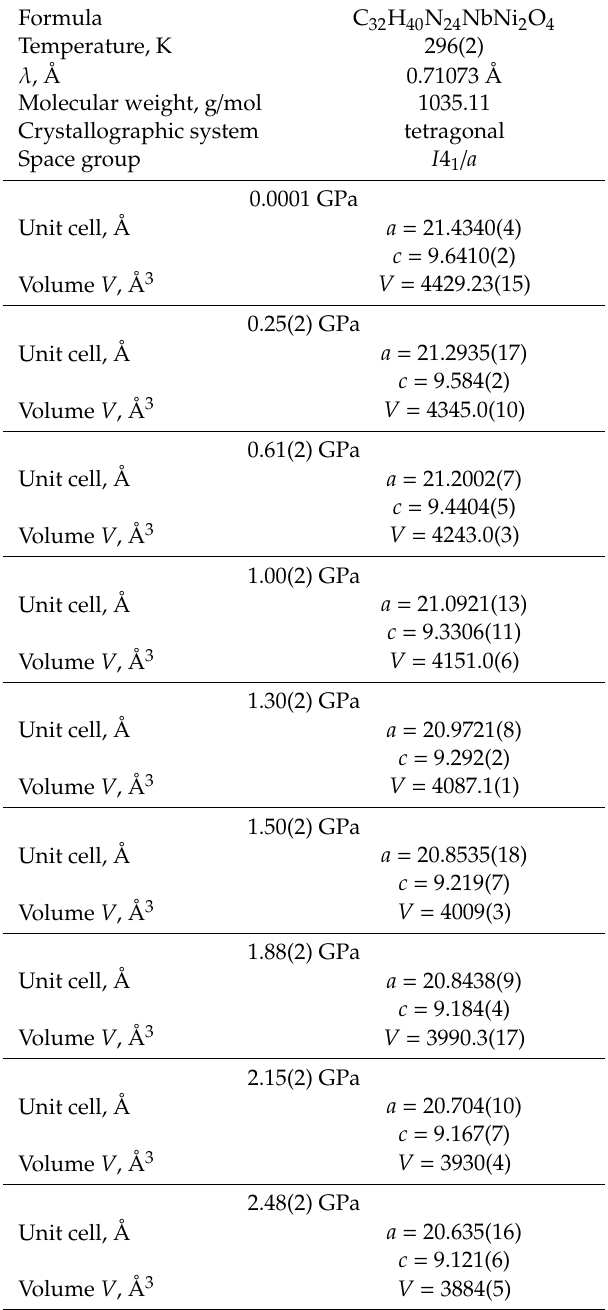
Table 1. Single-crystal X-ray di ff raction (scXRD) unit-cell parameters for Ni 2 Nb at room temperature and high